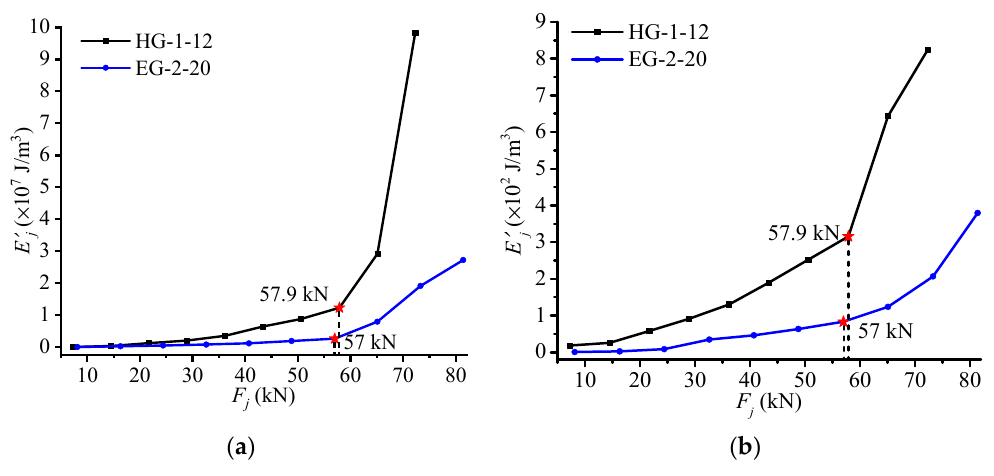
(cid:48) E F − curves using expanded strains. Figure 12. ( a ) The E (cid:48) − F j curves using expanded j j j